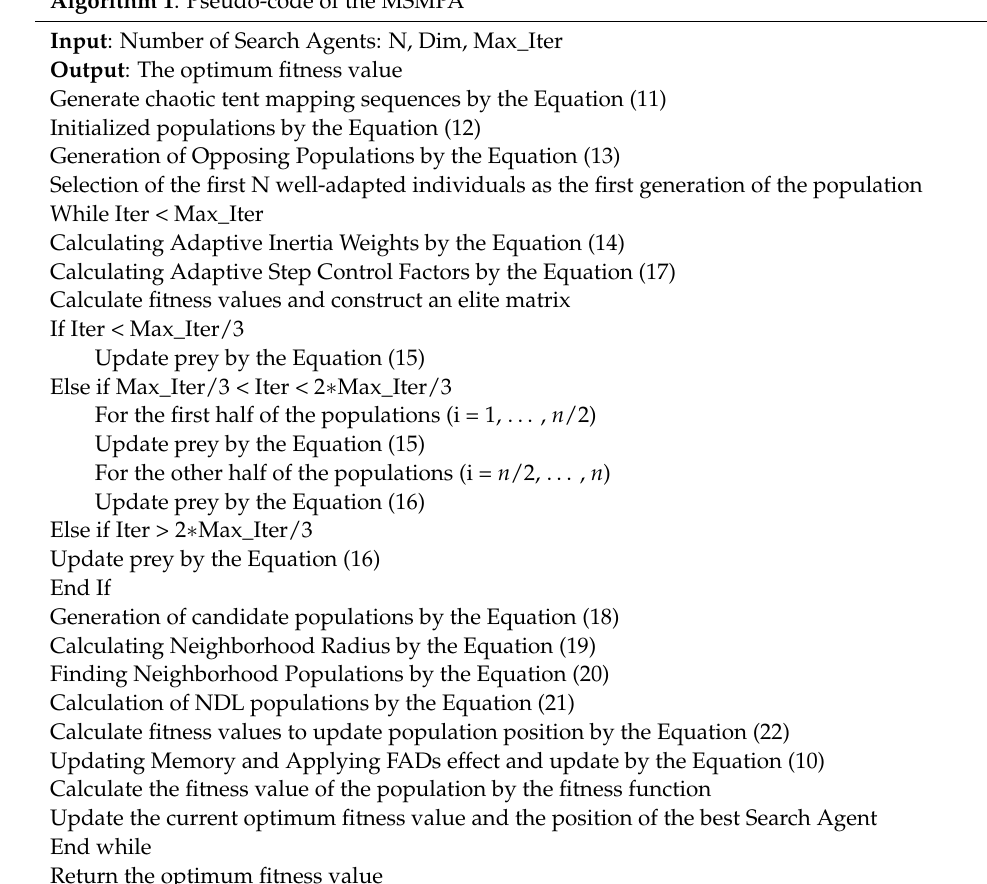
Algorithm 1 . Pseudo-code of the